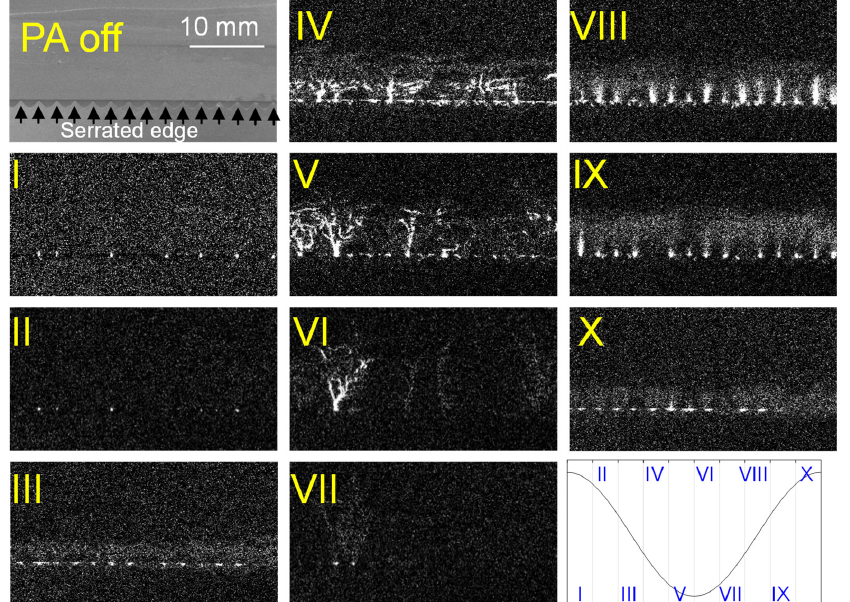
Figure 10. DBD emission images of the surface of the string-array-type PA with 12 wires in 10 sections ( I ) to ( X ) of the applied sinusoidal voltage, for P PA = 115.6 W/m ( V p-p = 20 kV).